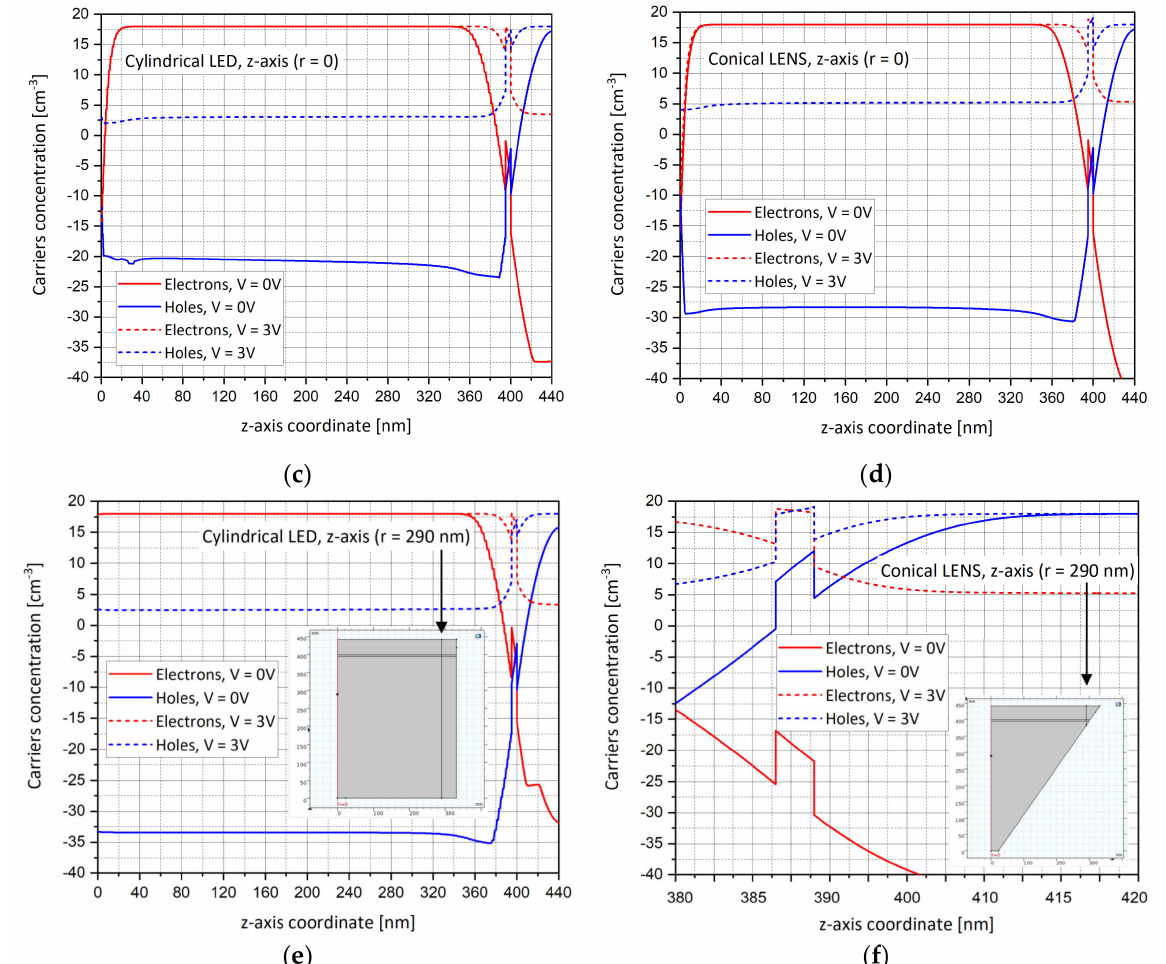
Figure 7. Simulations of carriers’ concentration for zero bias (0 V) and forward bias (3 V). ( a ) Holes’ concentration for cylindrical shape (LED) along x-axis (z = 442 nm, surface plane), There is a depletion of majority carries (holes) near the edge for the cylindrical device; ( b ) Holes’ concentration for conical shape (LENS) along x-axis (z = 442 nm, surface plane). There is an accumulation of holes near the edge for the conical device. ( c ) Carriers’ concentration for cylindrical shape (LED) shape along z-axis (r = 0); ( d ) Carriers’ concentration for cylindrical shape (LENS) shape along z-axis (r = 0). At r = 0, both LED and LENS present similar distributions. ( e ) Carriers’ concentration for cylindrical shape (LED) shape along z-axis (r = 290 nm); ( f ) Carriers’ concentration for cylindrical shape (LENS) shape along z-axis (r = 290